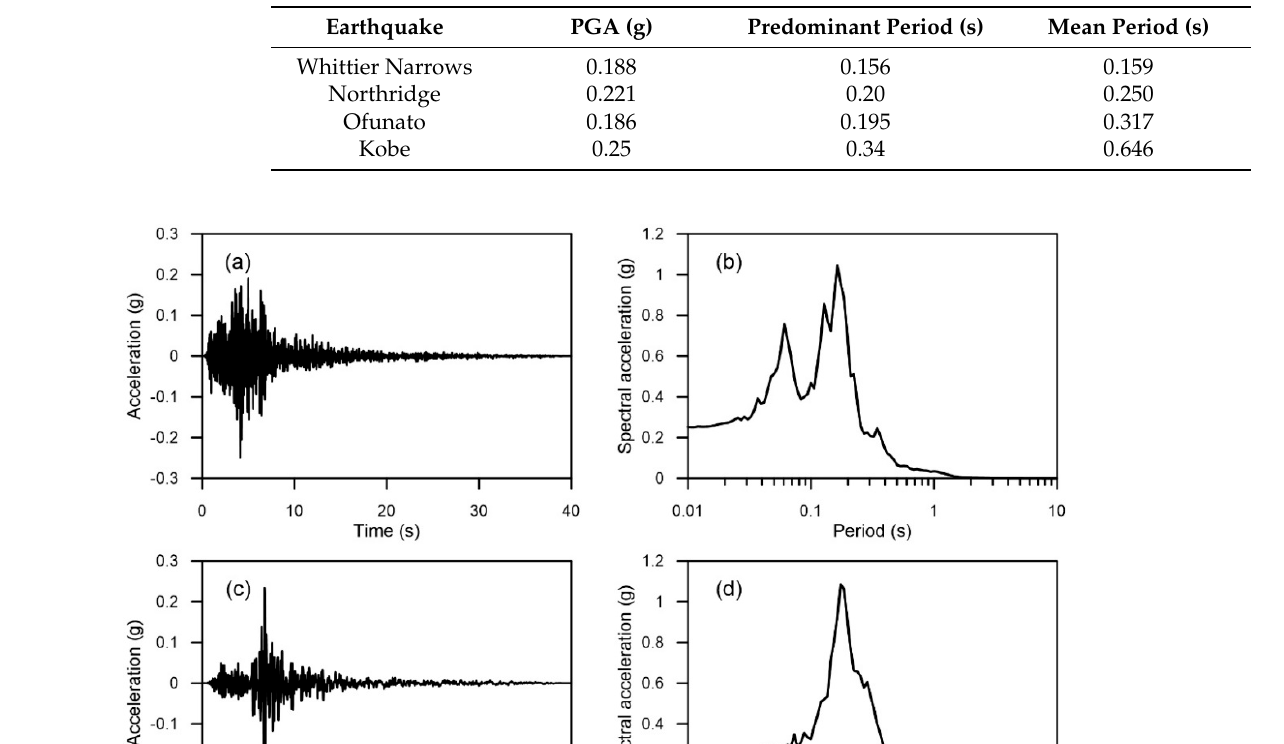
Table 2. Characteristics of input ground motions selected for dynamic analyses.